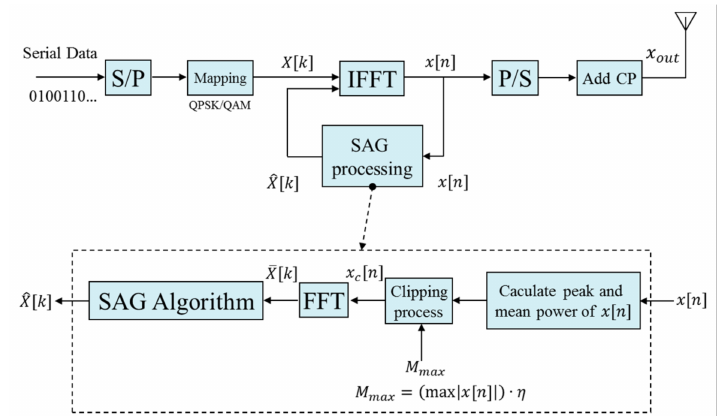
Figure 1. Block diagram of the PAPR reduction in OFDM signals by the proposed SAG